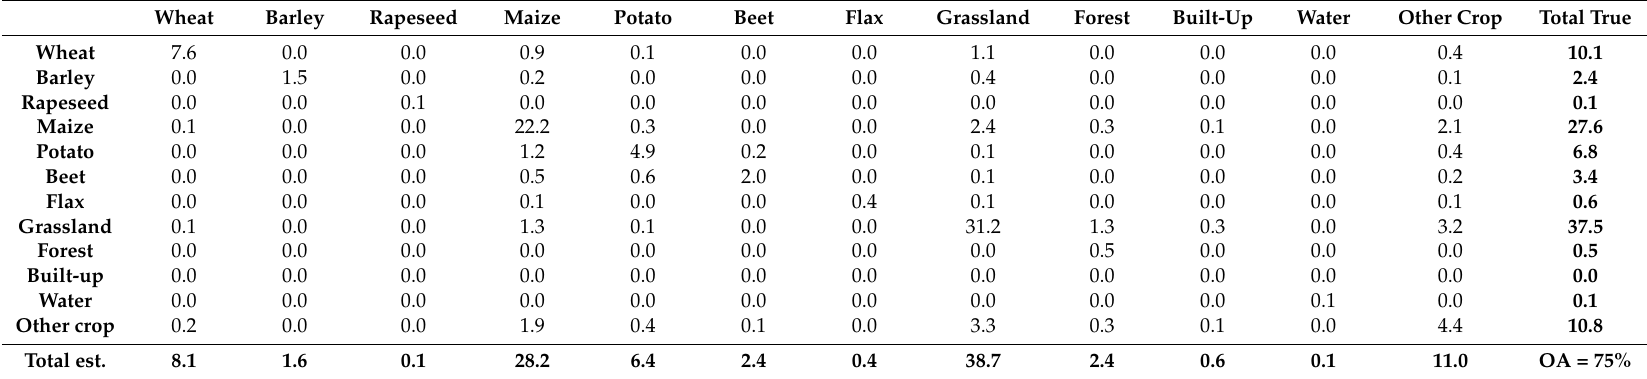
Table 3. Confusion matrix for early mapping in June 2017 using Sentinel-1 and -2 inputs. Small differences in “total true” and “total estimated” between Tables 3 and 4 are due to rounding.